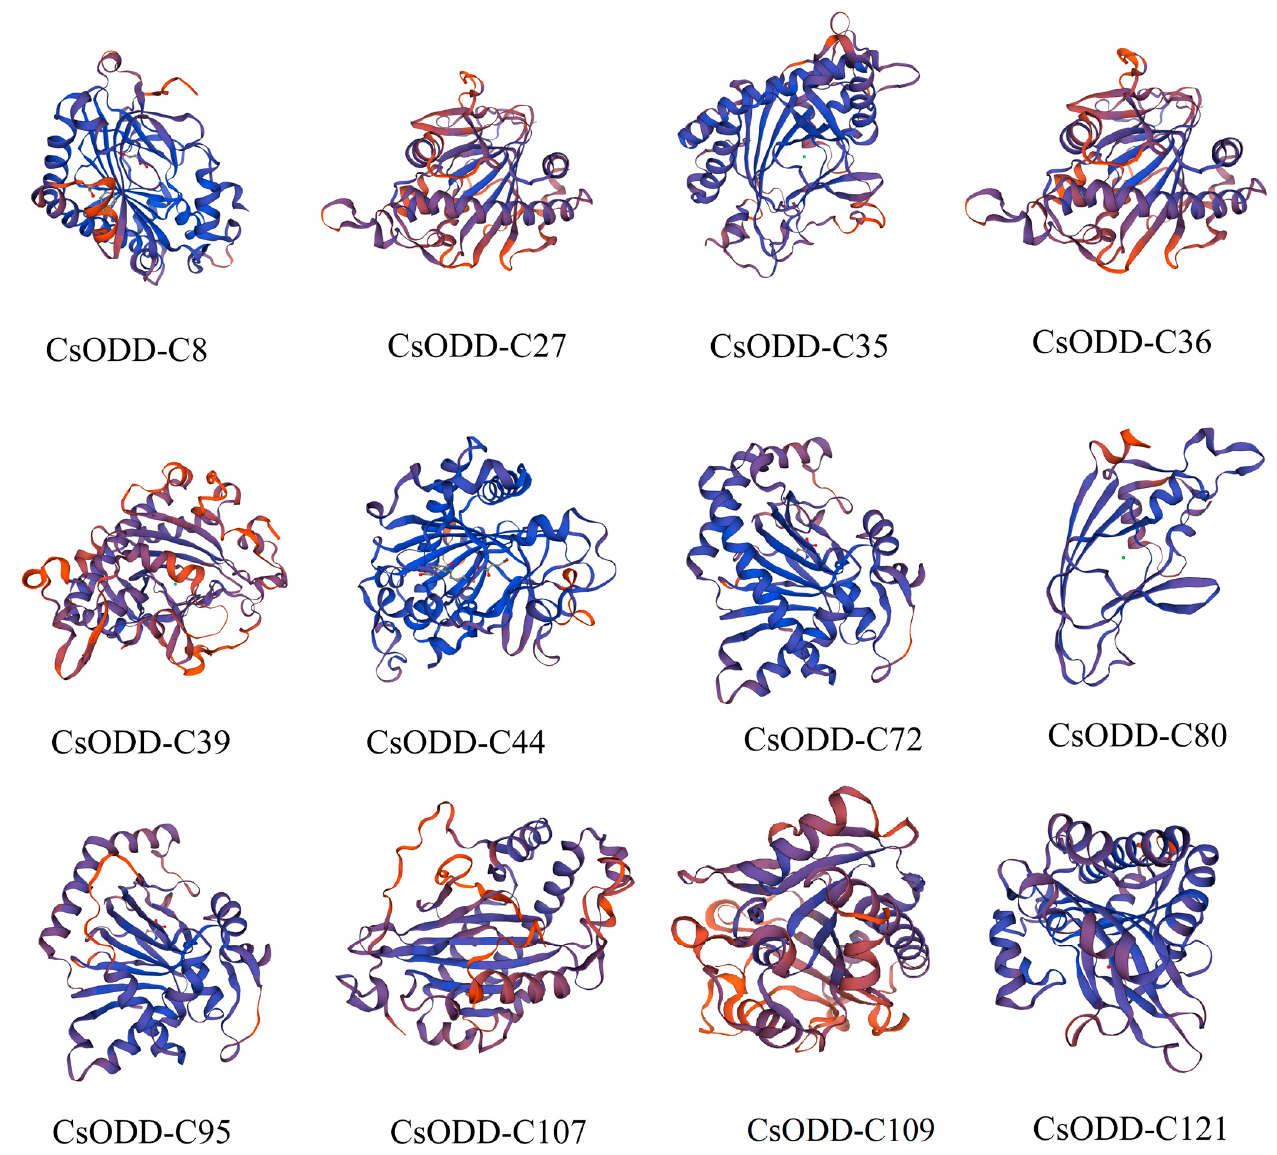
Figure 10. Tertiary structures of 12 candidate Cs2ODD − Cs. The tertiary structure of the protein was analyzed through the online SWISS-MODEL.